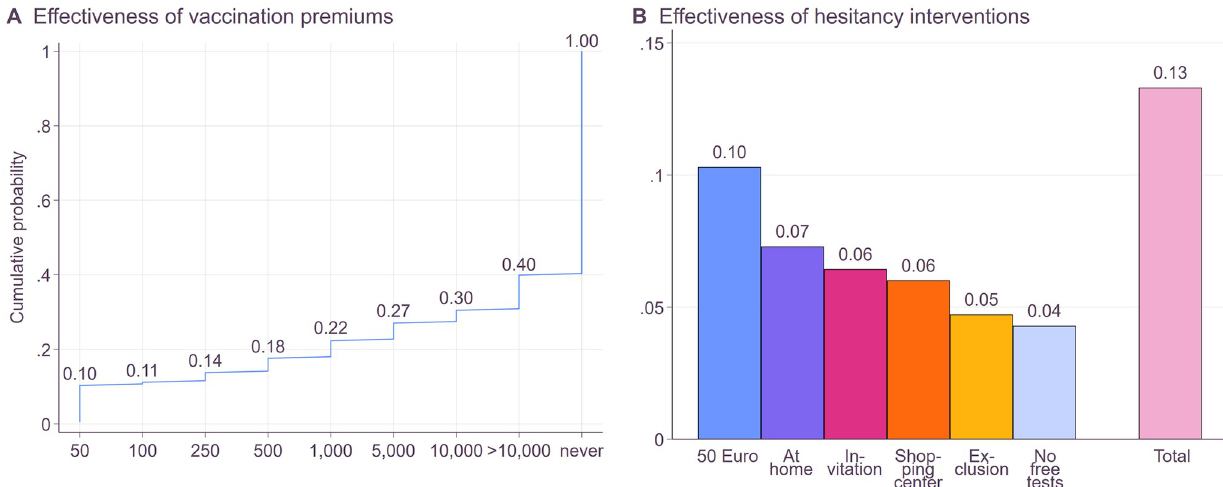
Fig 7. Effectiveness of interventions to decrease hesitancy. Panel A shows the cumulative distribution of unvaccinated participants who would vaccinate given a certain vaccination premium. We asked if they would vaccinate if they would receive a 50 Euro premium. If not, we repeated the question and increased the premium sequentially. Panel B shows the share of unvaccinated participants who would vaccinate given a 50 Euro premium if someone would come to their home to vaccinate them if they received an invitation to get vaccinated if they could vaccinate in a shopping center, if unvaccinated people were excluded from public events, or if the government would stop providing free COVID-19 tests. The final column to the right shows the total share of participants who stated an intention to vaccinate in one of the 6 hypothetical